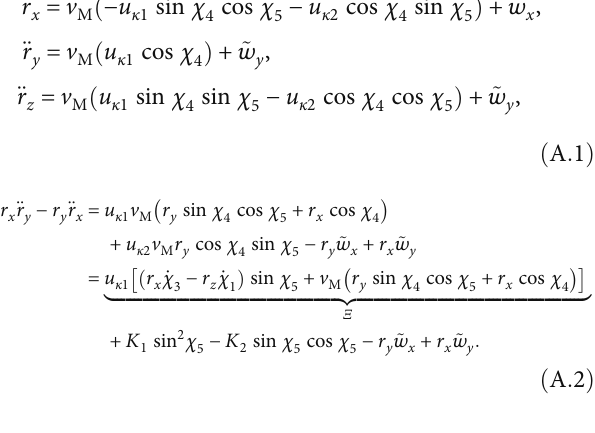
Figure 35: Statistical distribution and cumulative frequency of the minimum distance between the interceptor and obstacles.